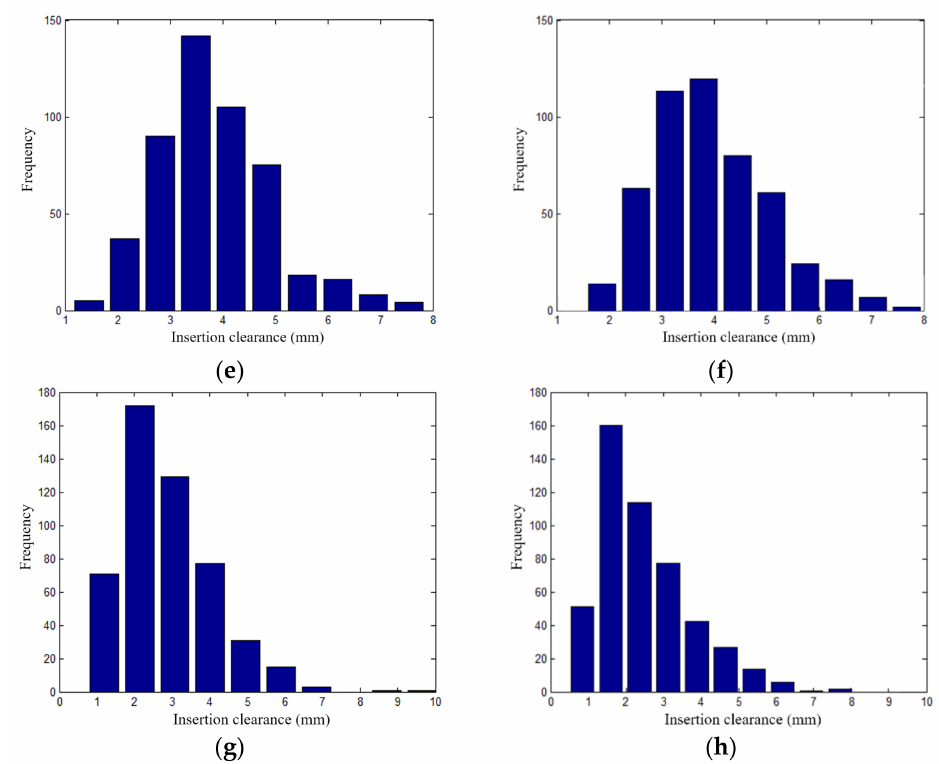
Figure 14. Error frequency distribution of the insertion clearances and joint openings under different assembly sequences. ( a ) Insertion clearance of block F under scheme i; ( b ) Insertion clearance of block F under scheme ii; ( c ) Insertion clearance of block LZ under scheme i; ( d ) Insertion clearance of block LZ under scheme ii; ( e ) Maximum opening of the circumferential seam under scheme i; ( f ) Maximum opening of the circumferential seam under scheme ii; ( g ) Maximum opening of the longitudinal joint under scheme i; ( h ) Maximum opening of the longitudinal joint under scheme ii.